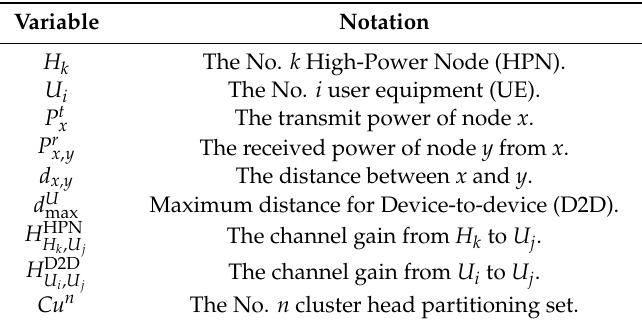
Table 1. Variable declaration.